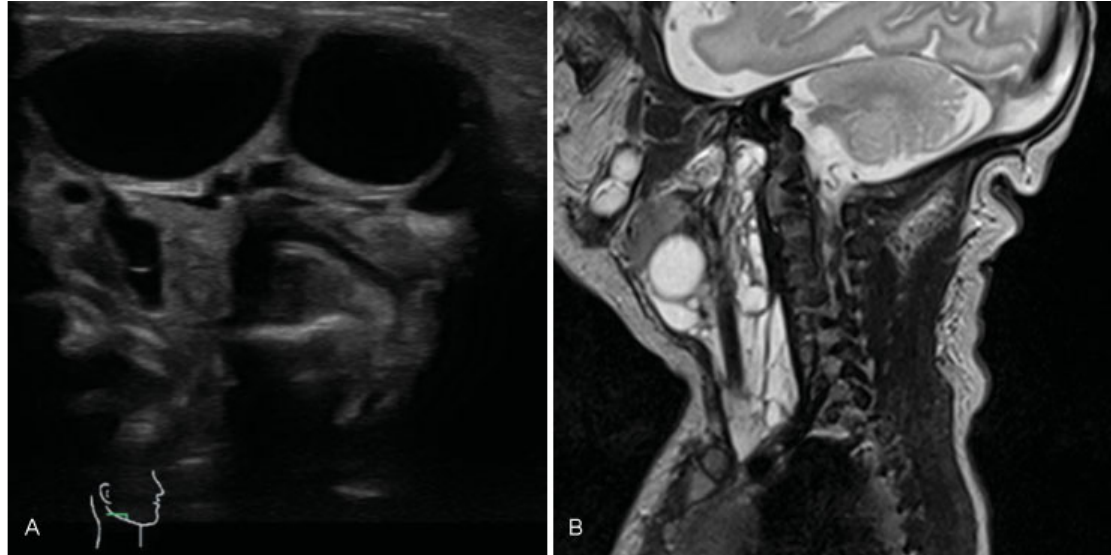
Fig. 1 ( A ) Duplex sonography of the right neck region obtained on the fi rst day of life showing the vertebral artery and multiple hypoechogenic cysts ofdifferent size representinga mixed-type lymphangioma. ( B ) Magnetic resonance imaging scan of the neck region showing multiple cysts of different size extending from the skull base to the upper thoracic aperture in the anterior region of the